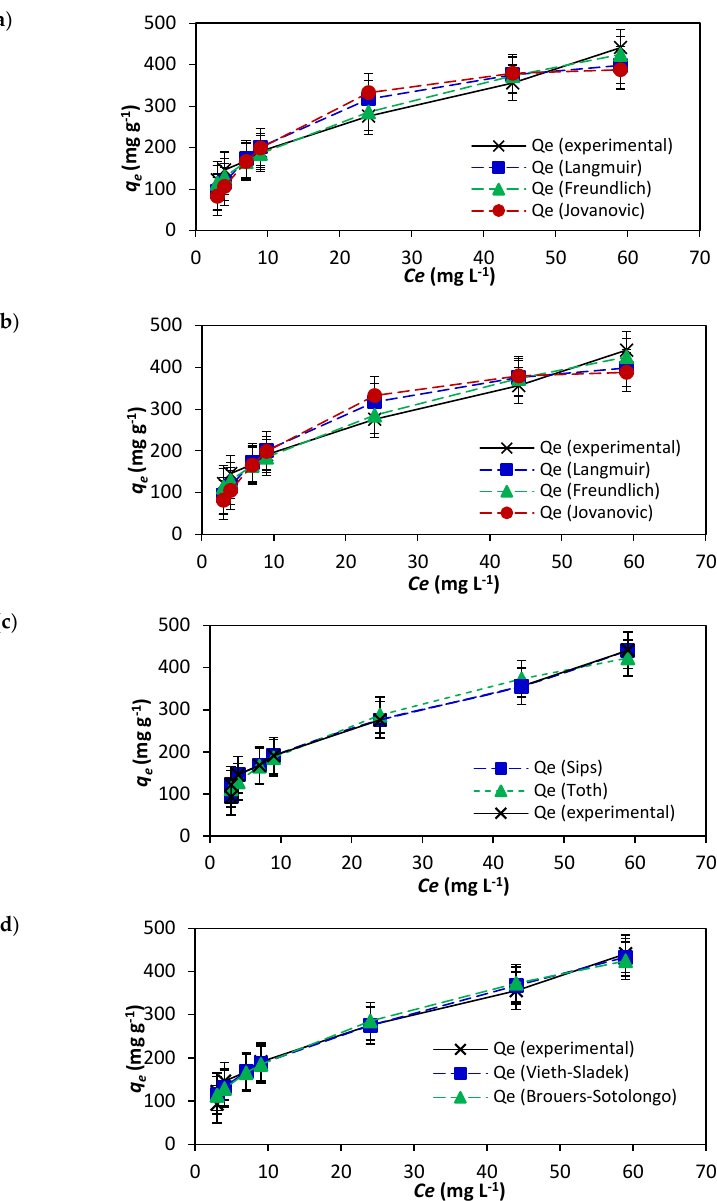
Figure 8. Fitting of adsorption data to ( a ) Langmuir, Freundlich and Jovanovic models, ( b ) Redlich– Peterson and Radke–Prausnitz models, ( c ) Sips and Toth models and ( d ) Vieth–Sladek and Brouers– Sotolongo adsorption isotherm models of the AR119 – NICUS system.